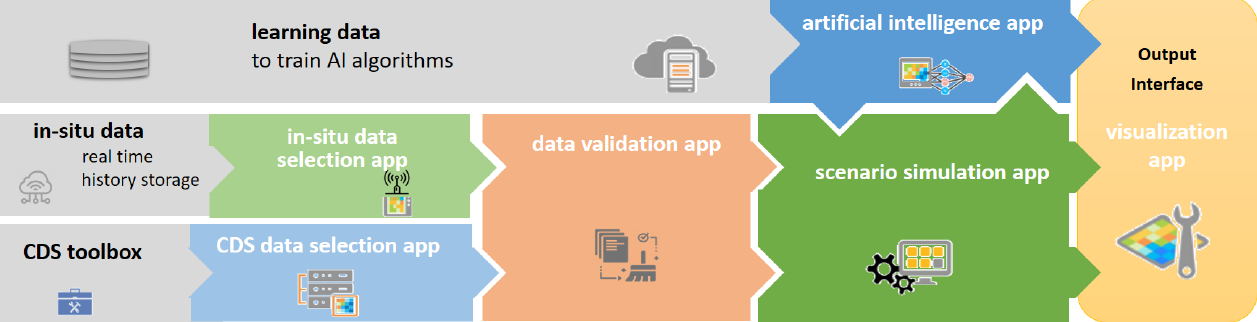
Figure 2. Schematic representation of the intended design of intuitively usable, modular apps (basic function modules). CoKLIMAx flexibly combines data and evaluation tasks in a module-like manner (based on the basic functionalities and scope of services of the AMCDS toolbox).